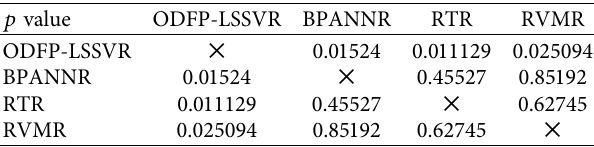
Table 5: Wilcoxon signed-rank test